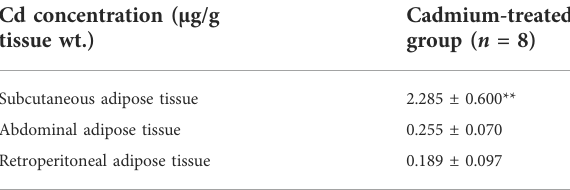
TABLE 2 Accumulation of cadmium in the different white adipose depots. Cd concentration (µg/g tissue